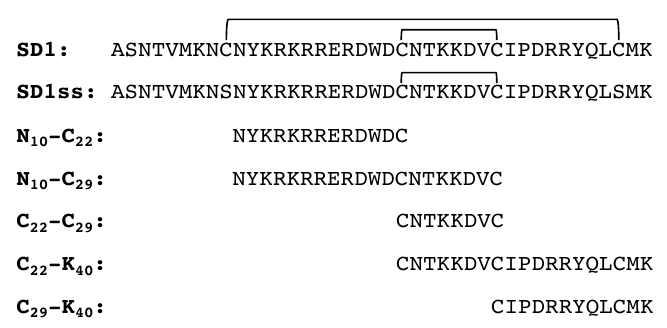
Figure 1. Synthetic peptides were designed to cover the subdomain 1 (SD1) region of DBPII. The subscript numbers indicate the amino acid position in the parent SD1 peptide. Disulfide bonds are noted with horizontal